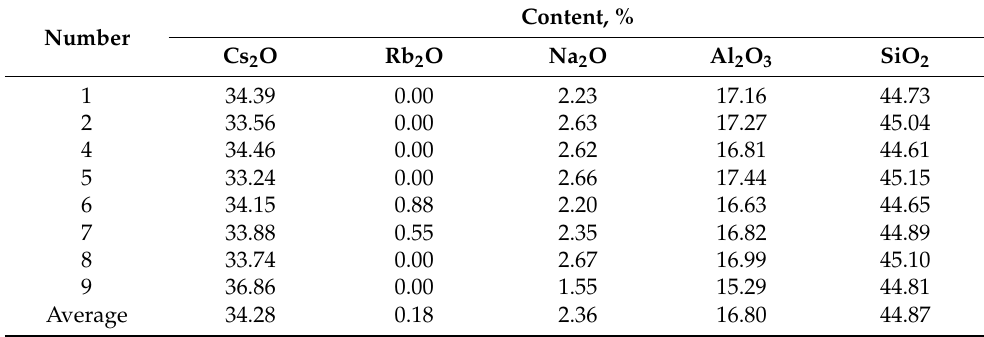
Table 6. Energy spectrum micro-domain composition analysis for pollucite.